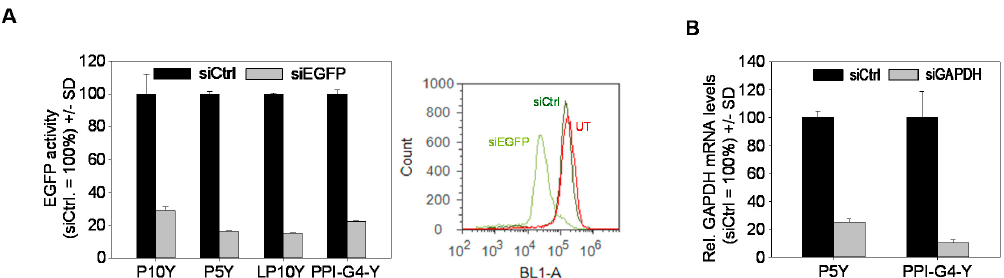
Figure 3. ( A ) Knockdown efficacies of various tyrosine-modified PPI- or PEI-based siRNA complexes targeting EGFP in PC3-EGFP/Luc cells (left). EGFP levels were determined by flow cytometry (see right panel and Figure S2C for original data). ( B ) Reduction of GAPDH mRNA levels in PC3 cells.